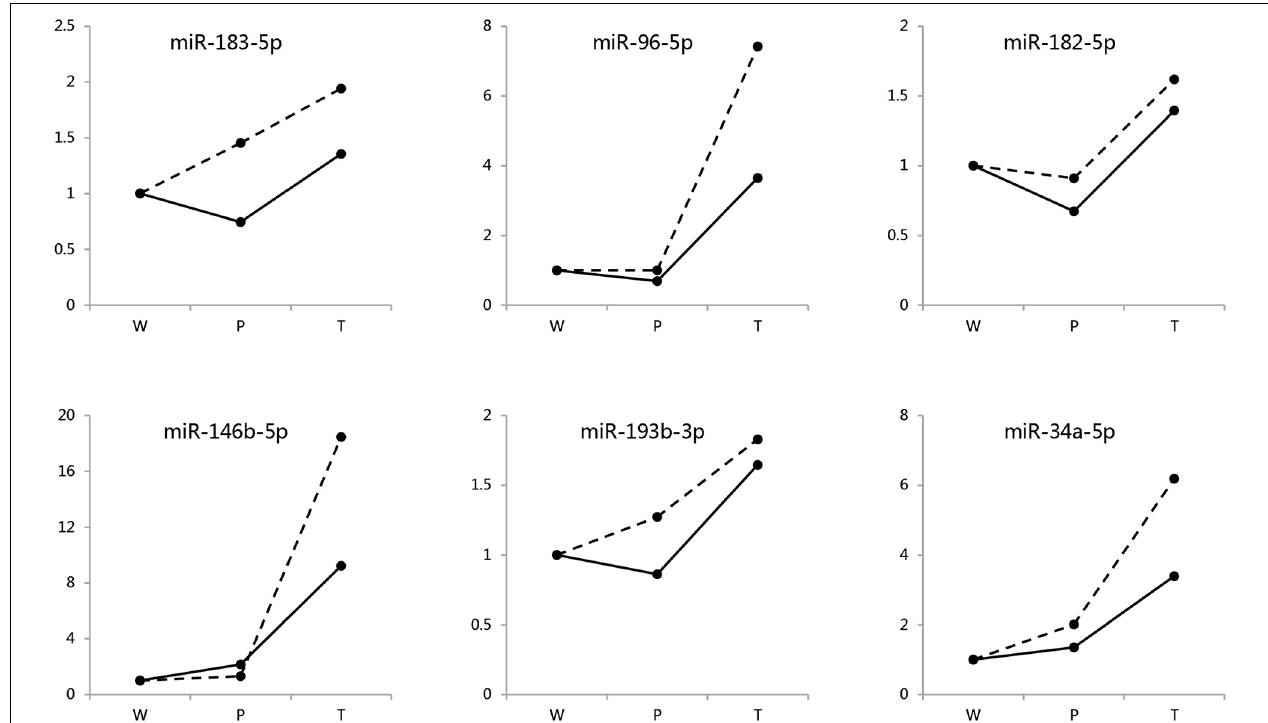
FIGURE 2 | Validation for DEMIRs by RT-qPCR. Six randomly selected DEMIRs detected in both sexes were evaluated by RT-qPCR analysis. The primer sequences were presented in Supplementary Table 2.1 . Hidden line, males; Solid line, females.